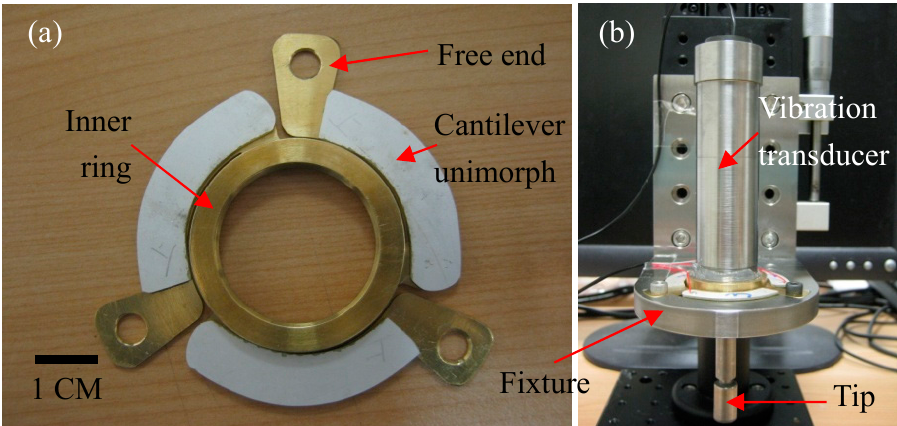
Figure 1. Energy harvester and the harvester-transducer-fixture assembly, ( a ) Energy harvester; ( b ) Vibration transducer assembly.